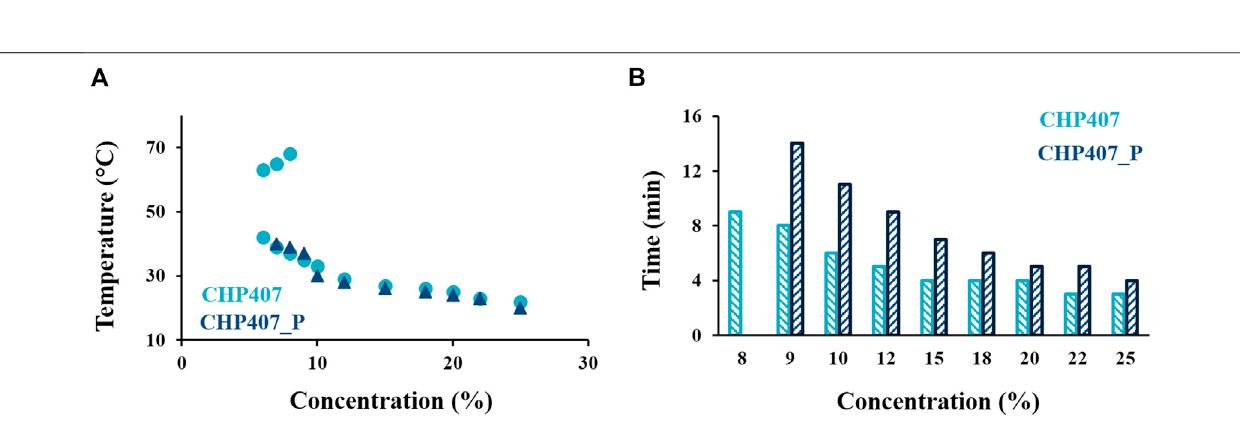
FIGURE 5| UV/Vis spectra recorded in the 330 – 400 nm wavelength range for CHP407 and CHP407_Pformulations (0.5% w/V concentration) upon temperature increase in the range 20 ° C – 26 ° C. The red dashed lines mark the absorbance measured at 356 nm.